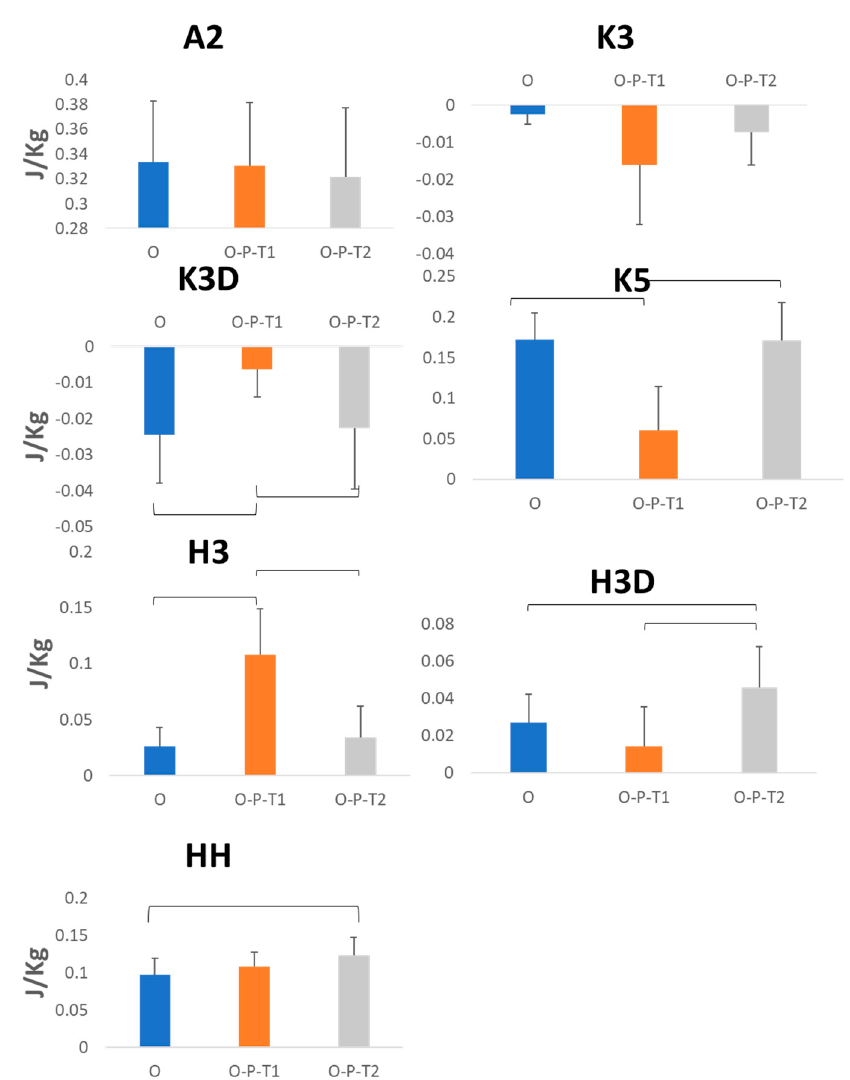
Figure 5. Average (standard deviation) of net muscle work corresponding to ankle push-off (A2); knee extensor absorption around (K3); after toe-off (K3D); after knee flexor generation (K5); hip flexor generation around toe-off (H3); hip flexor generation at mid-swing (H3D); and hip hiking around at toe-off (HH) across the unperturbed (O; blue), early perturbation of obstacle to platform (O-P-T1, orange) and late perturbation (O-P-T2, gray) trials.